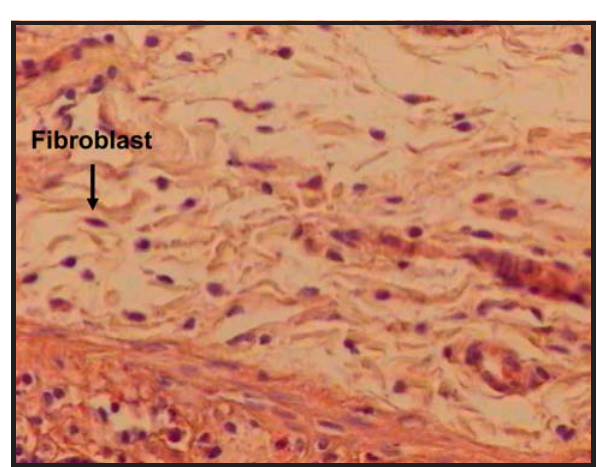
FIGURE 3 - Photomicrograph showing the presence of fibroblasts on the colon wall, utilizing hematoxylin-eosin staining